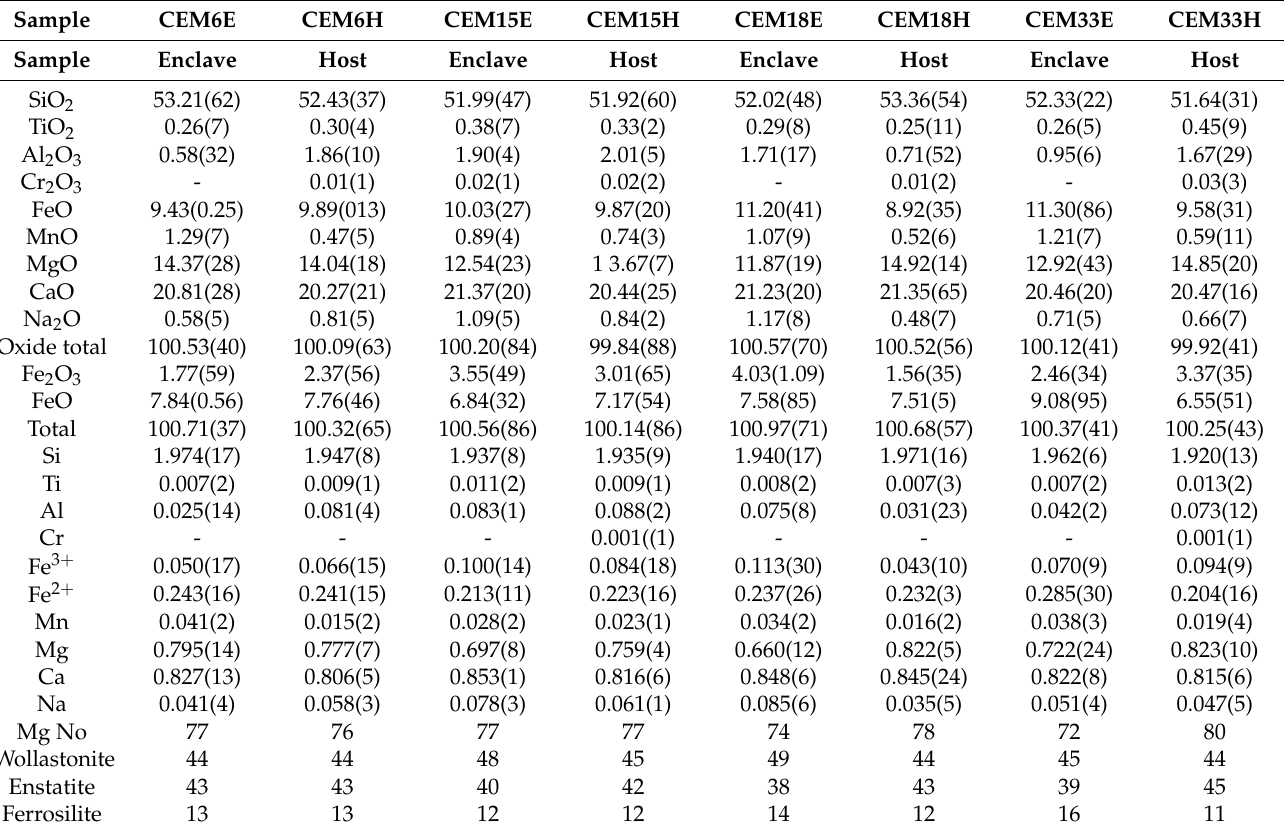
Table 2. Compositions (in weight percent) of major oxides for the studied clinopyroxenes. Cation partitioning based on six oxygen expressed in atoms per formula